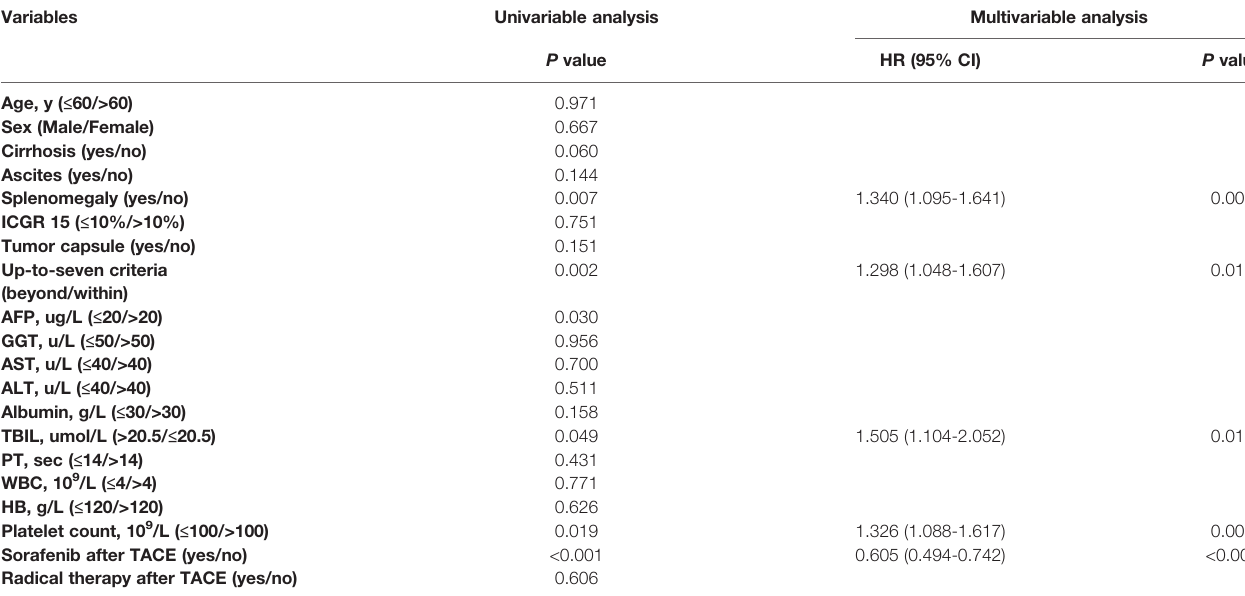
TABLE 2 | Univariable and multivariable analysis of OS in the VR group. Variables Univariable analysis Multivariable